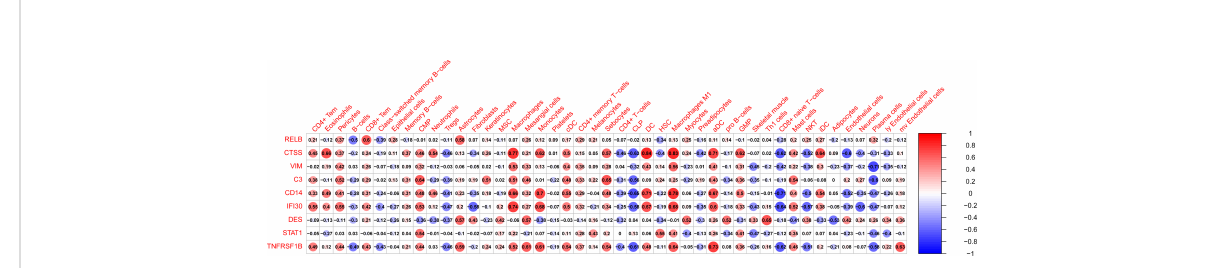
FIGURE 8 The correlation between hub genes and in fi ltrated immune and stromal cells. Size of the nodes represents the strength of the correlation between hub genes and in fi ltrated immune and stromal cells. The larger (or smaller) the nodes, the stronger (or weaker) the correlation. The redder the nodes, the stronger the positive correlation, the bluer the nodes, the stronger the negative